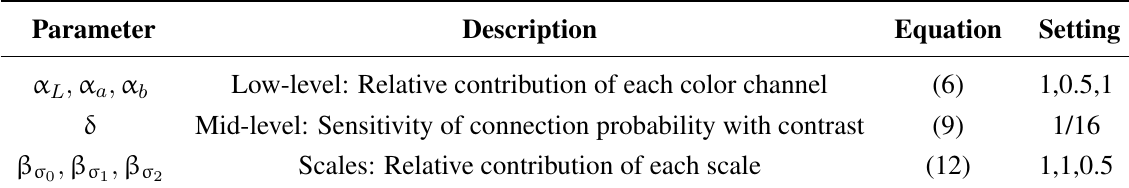
Table 1. Parameters involved in our model.